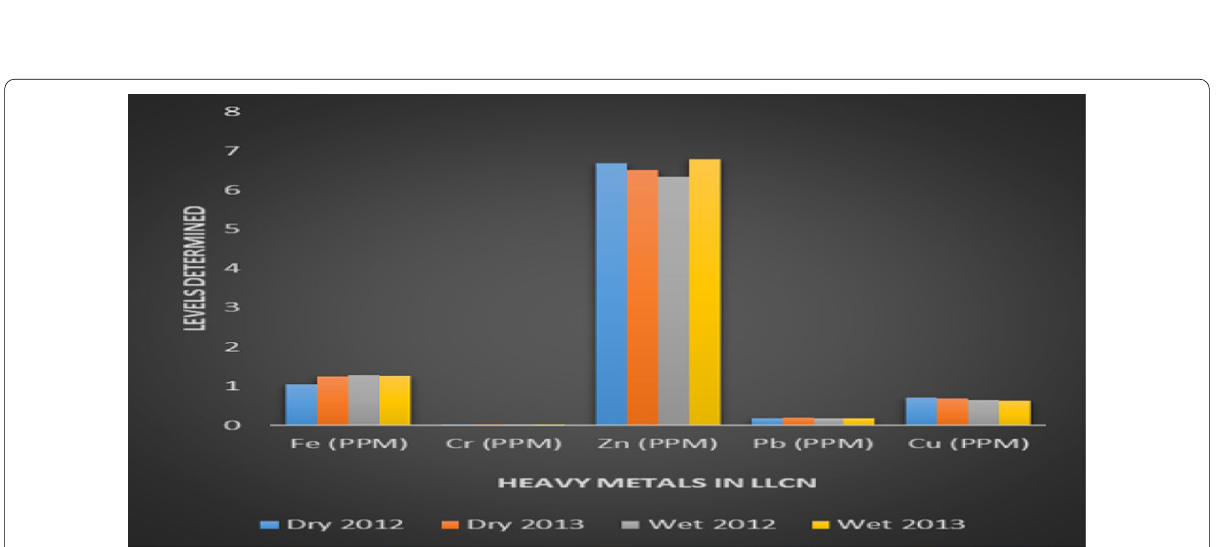
Fig. 11 Seasonal variations in heavy metals in C. nigrodigitatus collected from Lagos Lagoon